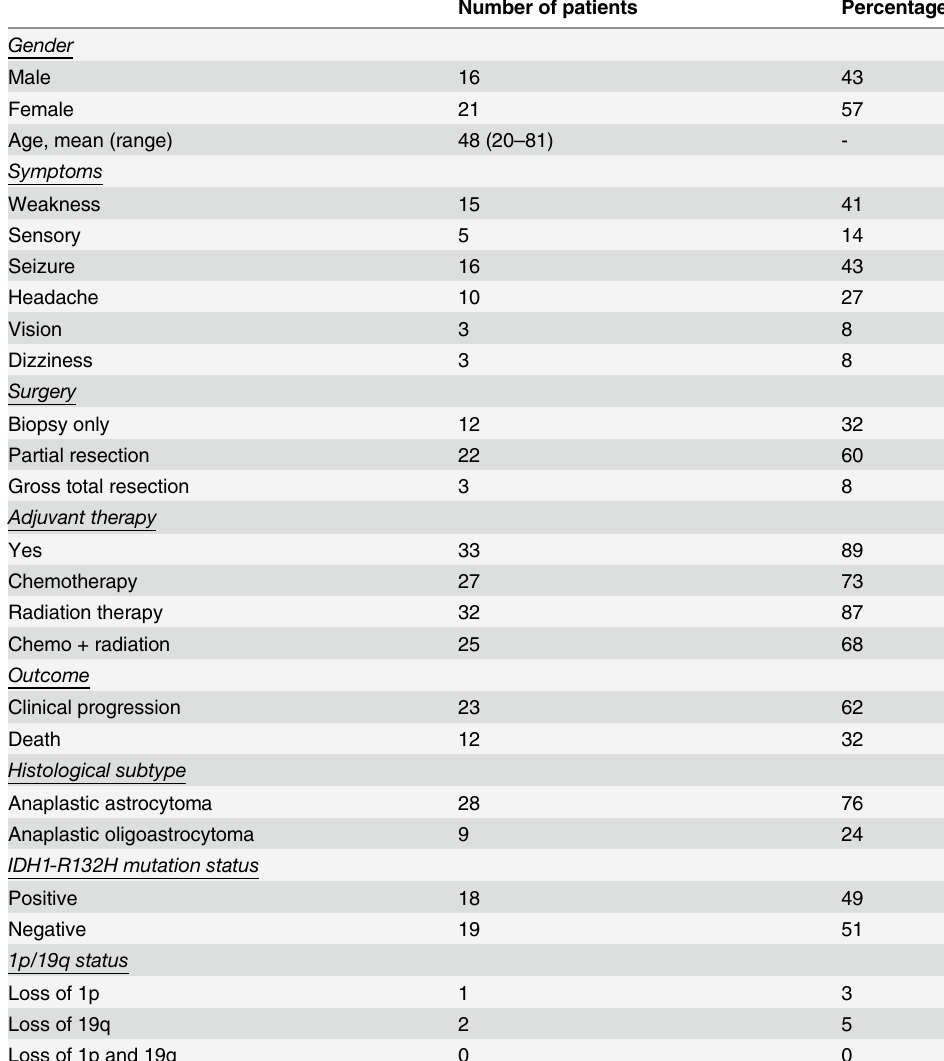
Table 2. Demographic, clinical, and molecular data for patients with newly diagnosed anaplastic as- trocytic tumours.